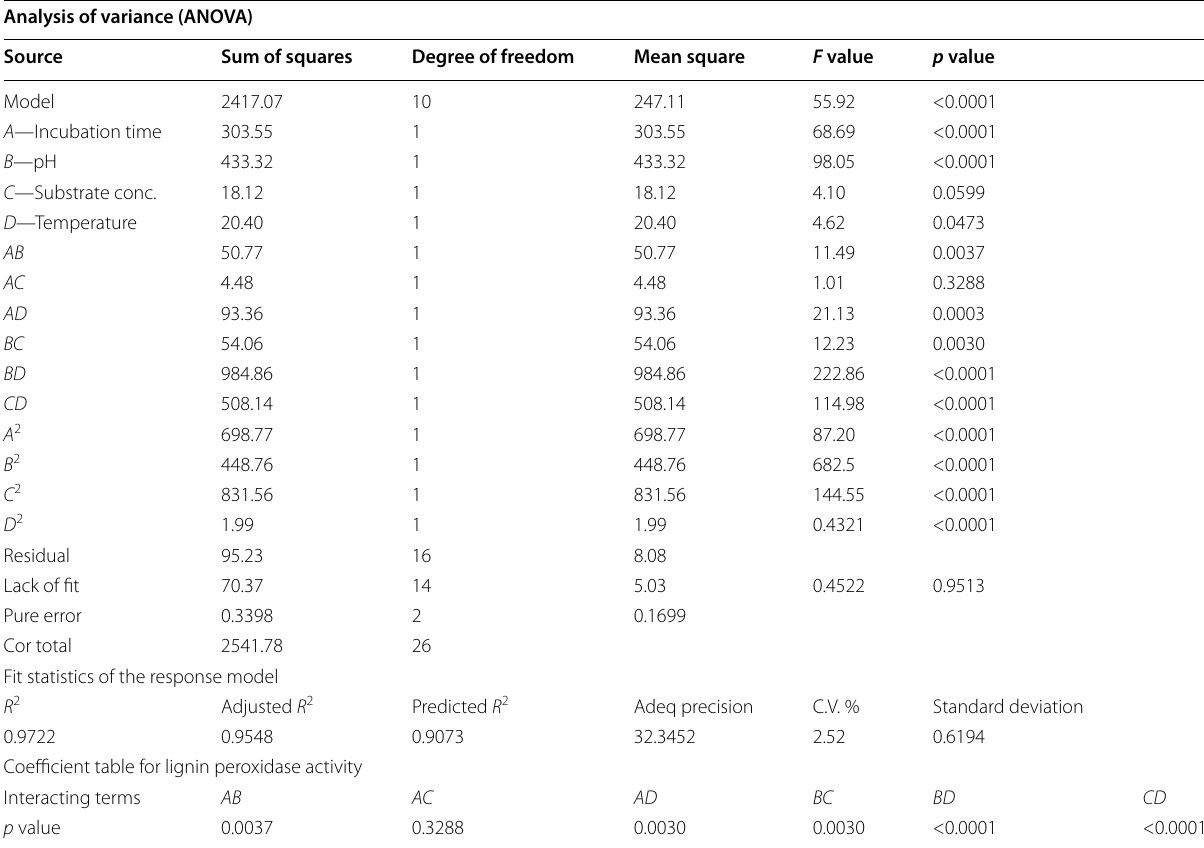
Table 3 Analysis of variance (ANOVA), Fit statistic of response model, and coefficient table for LiP enzyme activity of Bacillus mycoides Analysis of variance